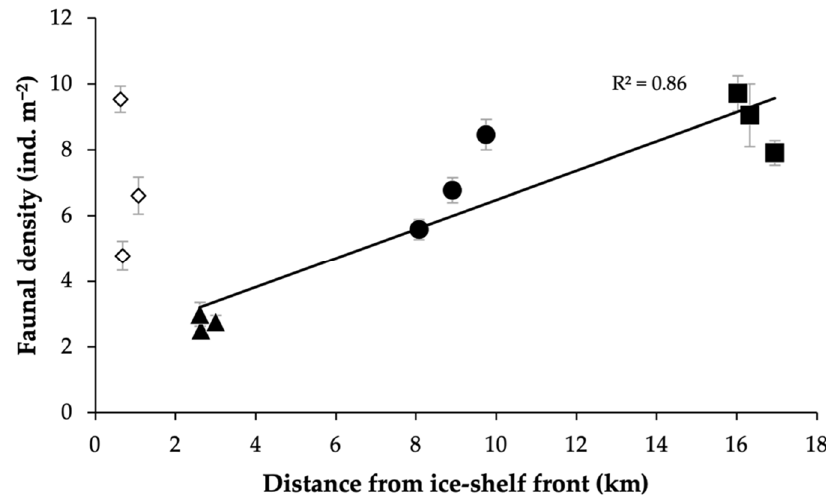
Figure 3. Megafaunal density generally increases with distance from the ice shelf. Mean benthic megafaunal density (ind. m −2 ) (±SE) of each sample (three per site) with distance from the ice-shelf front (km). Mean density (±SE) calculated for each sample using associated frames (minimum of 44 frames per data point). Site LCP1 = diamonds, LCP2 = triangles, LCP3 = circles, and LCP4 = squares. Symbols filled in white excluded from regression statistics (hence trend-line generation) (owing to water mass differences, see [90]).